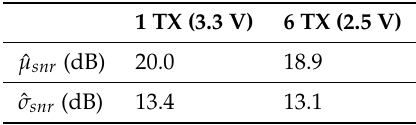
Figure 17. Signal-to-noise ratio (SNR) histogram obtained using (12) for all RXs. Table 7. SNR mean and standard